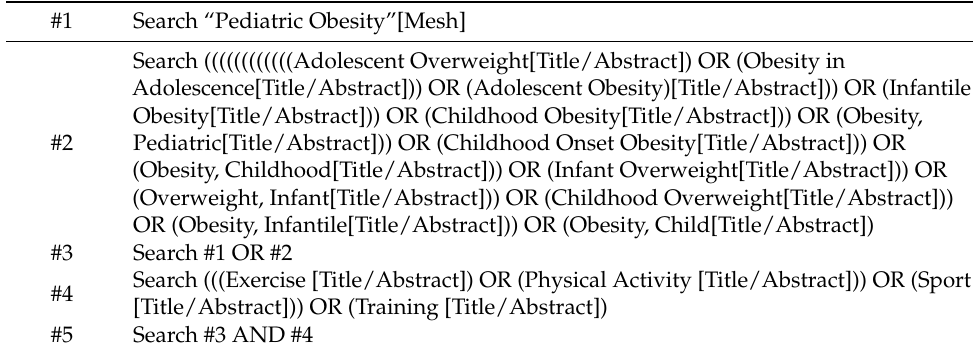
Table 1. Search strategy on